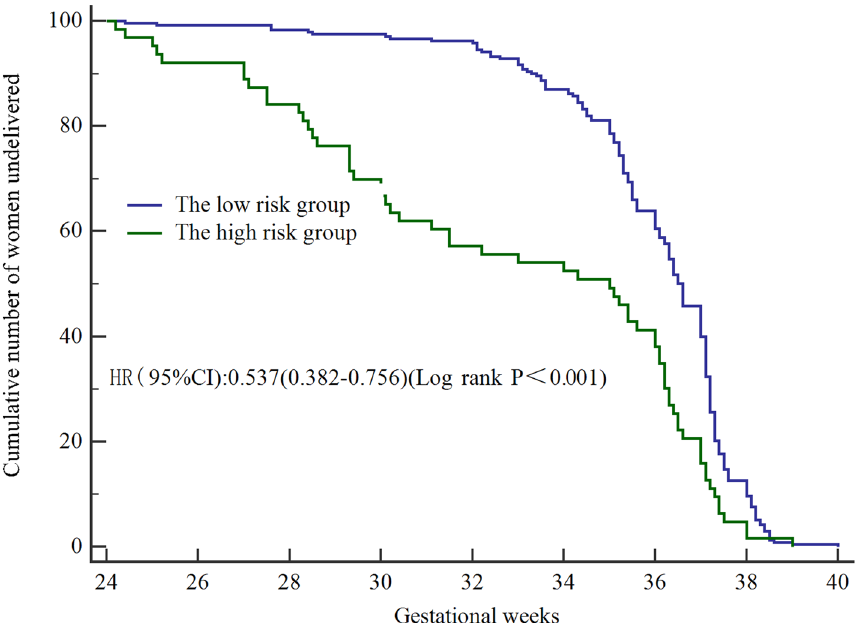
Figure 8. Survival curves of the high-risk group and the low-risk group in twin pregnancies. Kaplan–Meier curves were generated for GA at delivery. Log-rank test comparisons between the high-risk group and the